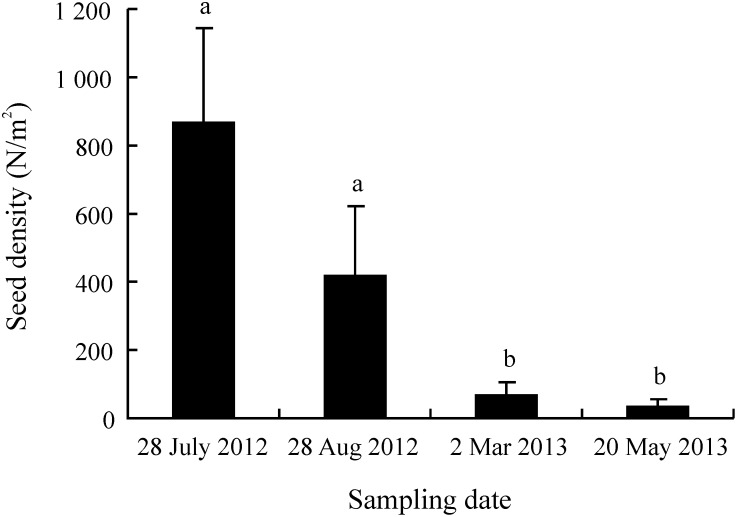
Seed density on different sampling dates in a S. bungeana-dominated grassland.Different letters indicate significant difference (P<0.05) among sampling dates (n = 16).